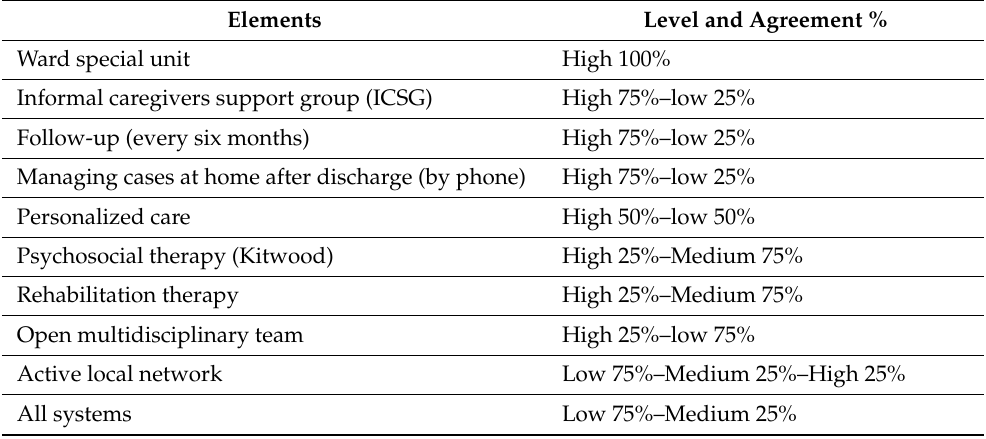
Table 6. Replicability of an SCU-B’s